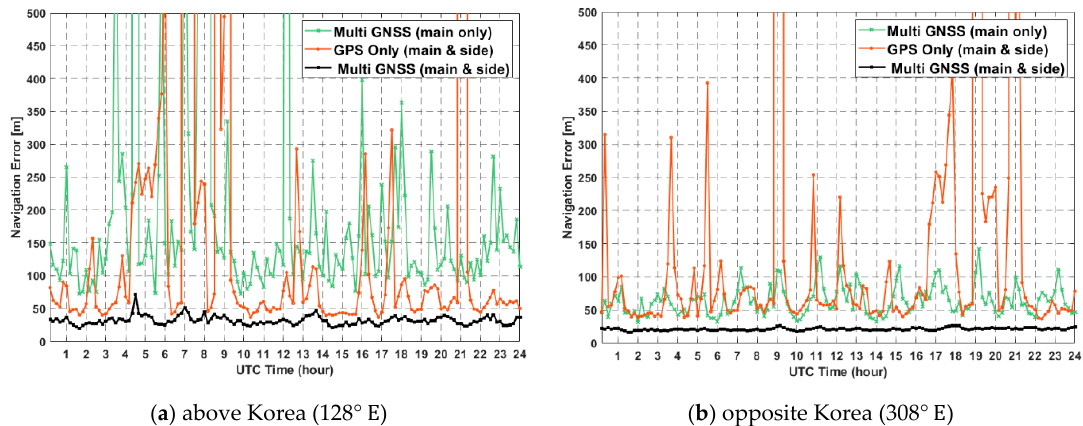
Figure 12. Position estimation error for 24 h in geostationary orbit.